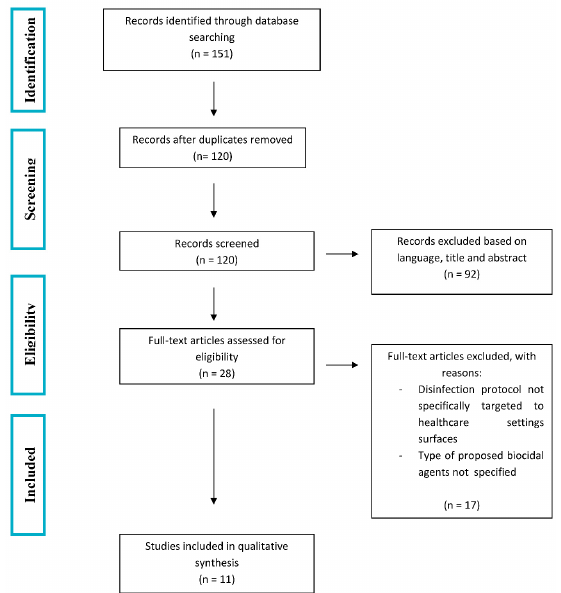
Figure 1. Flow chart of publication assessment.